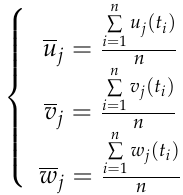
( d ) Figure 10. The influence of different parameters on the first 40 natural frequencies: ( a ) Span; ( b ) Rise–span; ( c ) Internal pressure; ( d ) Cable configuration.